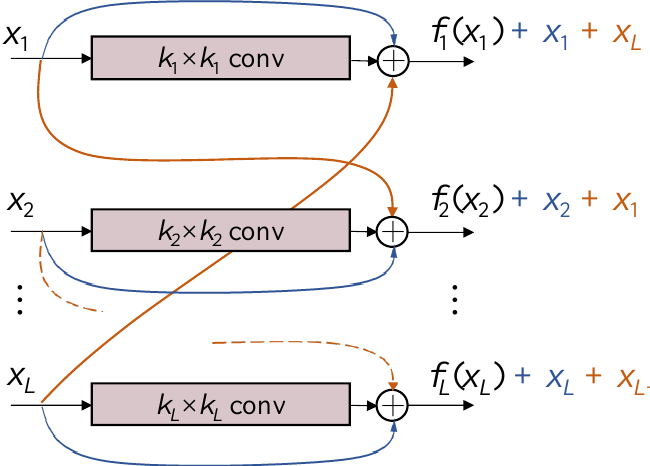
Figure 2. The illustration of the multi-level cross residual block. The residuals x are not only connected to the output of their existing layers, but also added to the cross layers. The residual in the last layer is connected to the output of the first layer. The conv means convolution + BN +